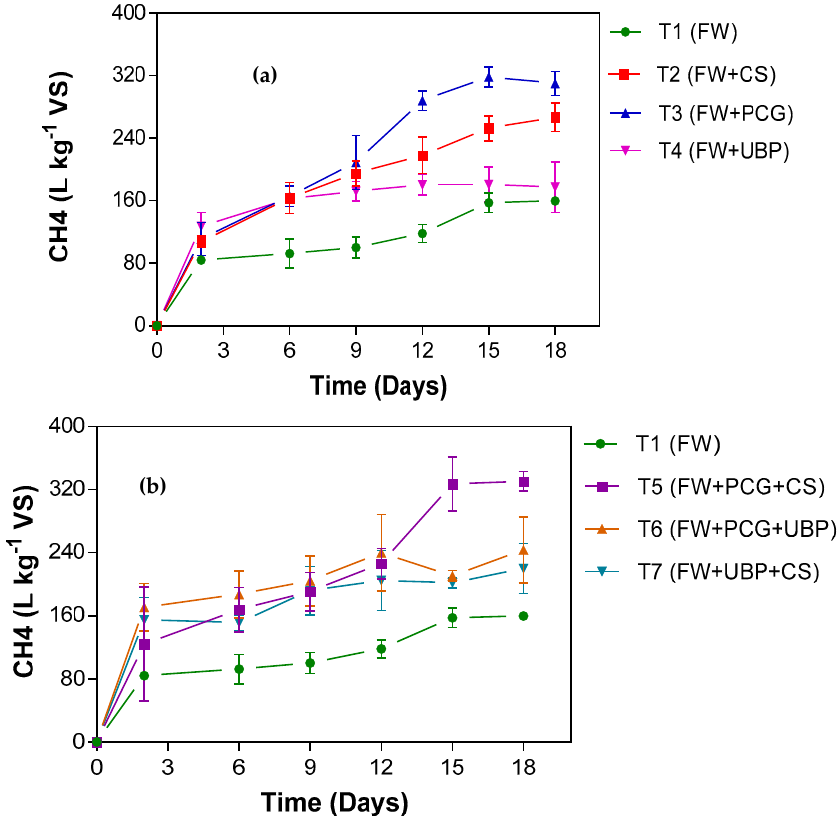
Figure 3. ( a , b ): methane production from the co-digestion of food and lignocellulosic waste (the data represented are the average values of triplicate bottles. The error bars represent the standard